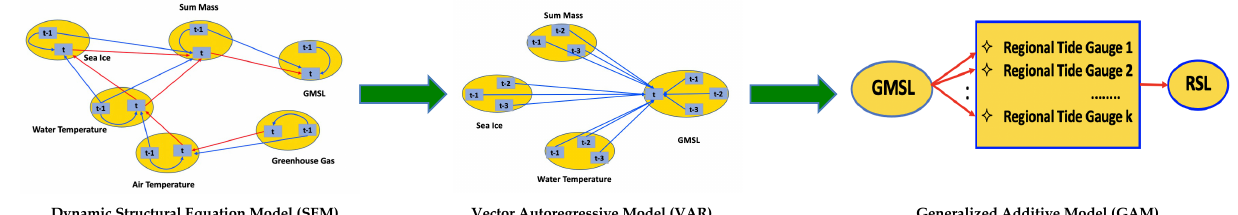
Figure 2. The proposed sea-level change analysis pipeline with three sequential steps: (1) a dynamic Structural Equation Model (SEM) to identify pathways between the global mean sea level (GMSL) and various predictors, (2) a Vector Autoregression Model (VAR) to quantify the GMSL changes due to the significant relations identified in the first step, and (3) a Generalized Additive Model (GAM) to model the relationship between regional sea level (RSL) and